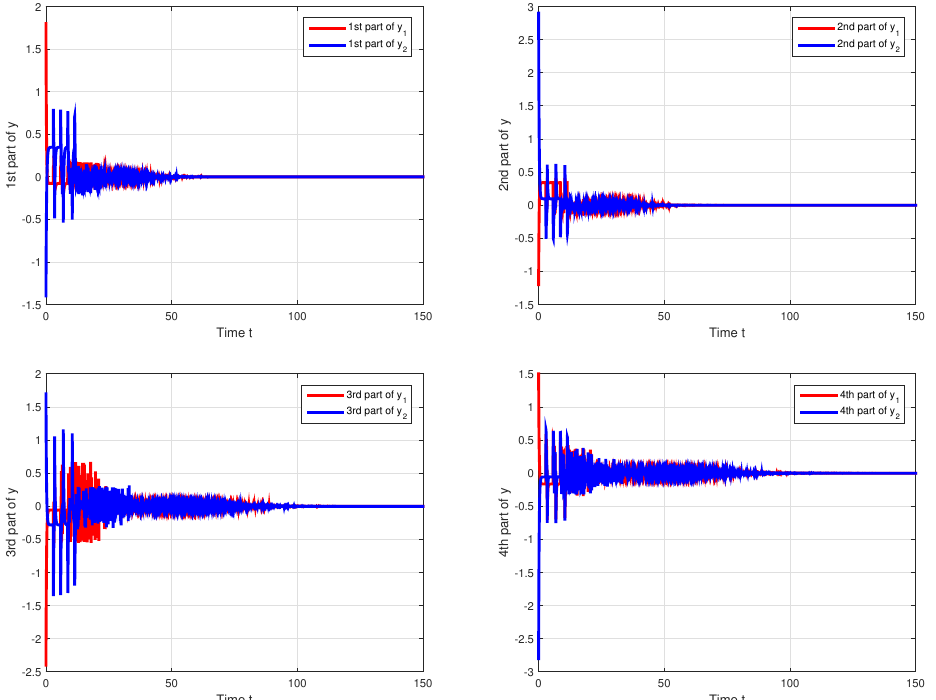
Figure 1. The four parts of the state trajectories for the quaternion-valued neutral-type neural networks (QVNTNNs) (Equation (1)) in Example 1.